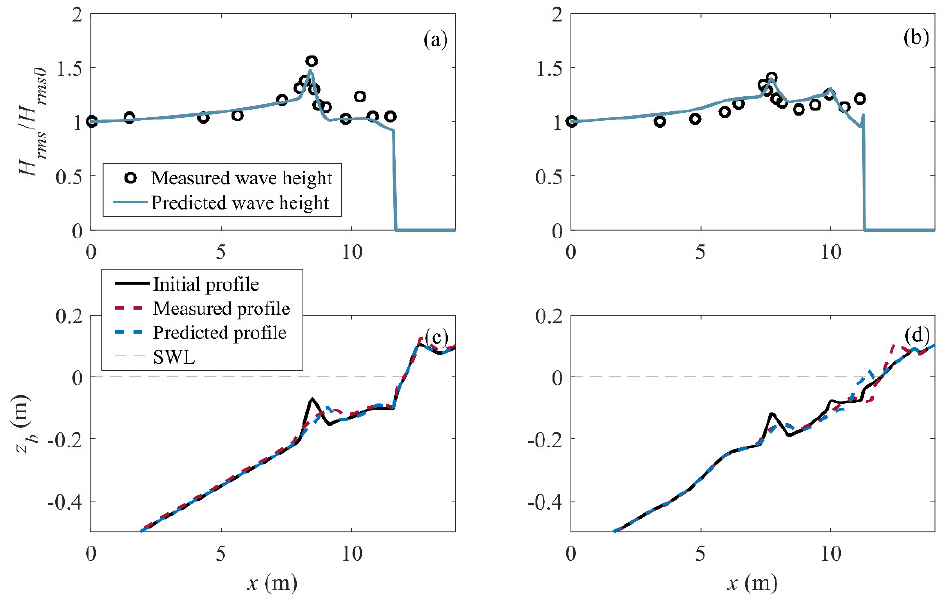
Figure 8. Modeling of wave height and profile evolution of A1_2 ( a , c ) and E1_1 ( b , d ). Based on model results, the overall beach profile evolution, as well as the crest and seaward/shoreward boundary of the shoreface nourishment are analyzed. As shown in Figure 9a, the crest of the nourishment migrates onshore from x = 8.5 m to x = 9 m with its elevation decreasing from z = − 0.07 m to z = − 0.1 m. The seaward boundary keeps almost unchanged during the onshore migration of the nourishment. It can be seen from Figure 8c that the model underestimates the offshore migration of seaward boundary of the nourishment. This is because the present model cannot represent the sediment transport driven by gravity diffusion [71,72]. The shoreward boundary moves onshore. These three curves turn to be stable after t = 225 min. Similarly, the crest of the nourishment in Figure 9b migrates onshore from x = 7.75 m to x = 7.95 m in case E1_1. Both seaward and shoreward boundaries are almost unchanged during shoreface nourishment onshore migration. The cross-shore span of the shoreface nourishment in E1_1 is smaller than that in A1_2. This is because the trough of the outer bar limits the range of migration of the shoreface nour- ishment for E1_1.